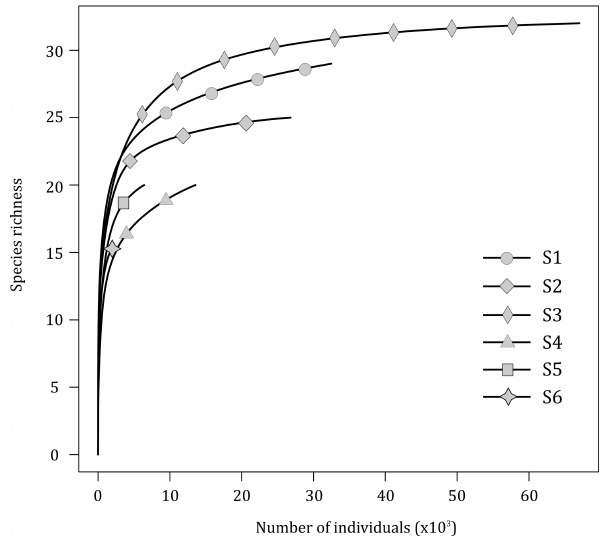
Figure 3. Rarefaction curves for species richness in the six vent samples (S1 to S6) collected on the Grotto hydrothermal